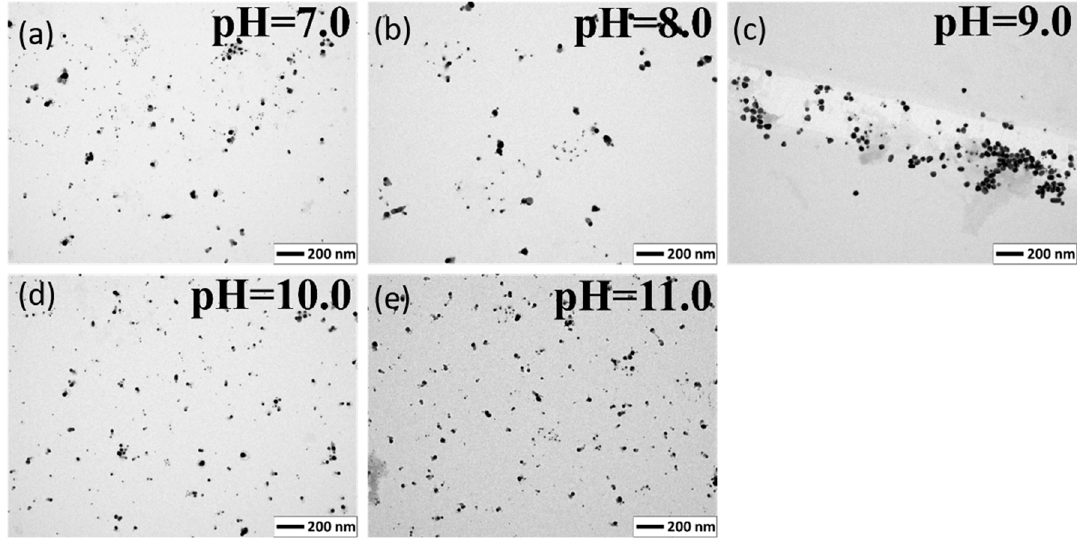
Figure 7. TEM images of the silver nanoparticles reduced by malic acid at pH 7.0 to 11.0. ( a ) pH = 7.0; ( b ) pH = 8.0; ( c ) pH = 9.0; ( d ) pH =10.0; ( e ) pH = 11.0.